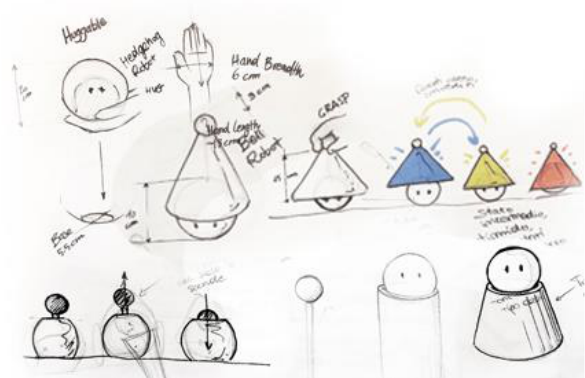
Figure 4 | A small set of sketches about the character’s design and possible alternatives.